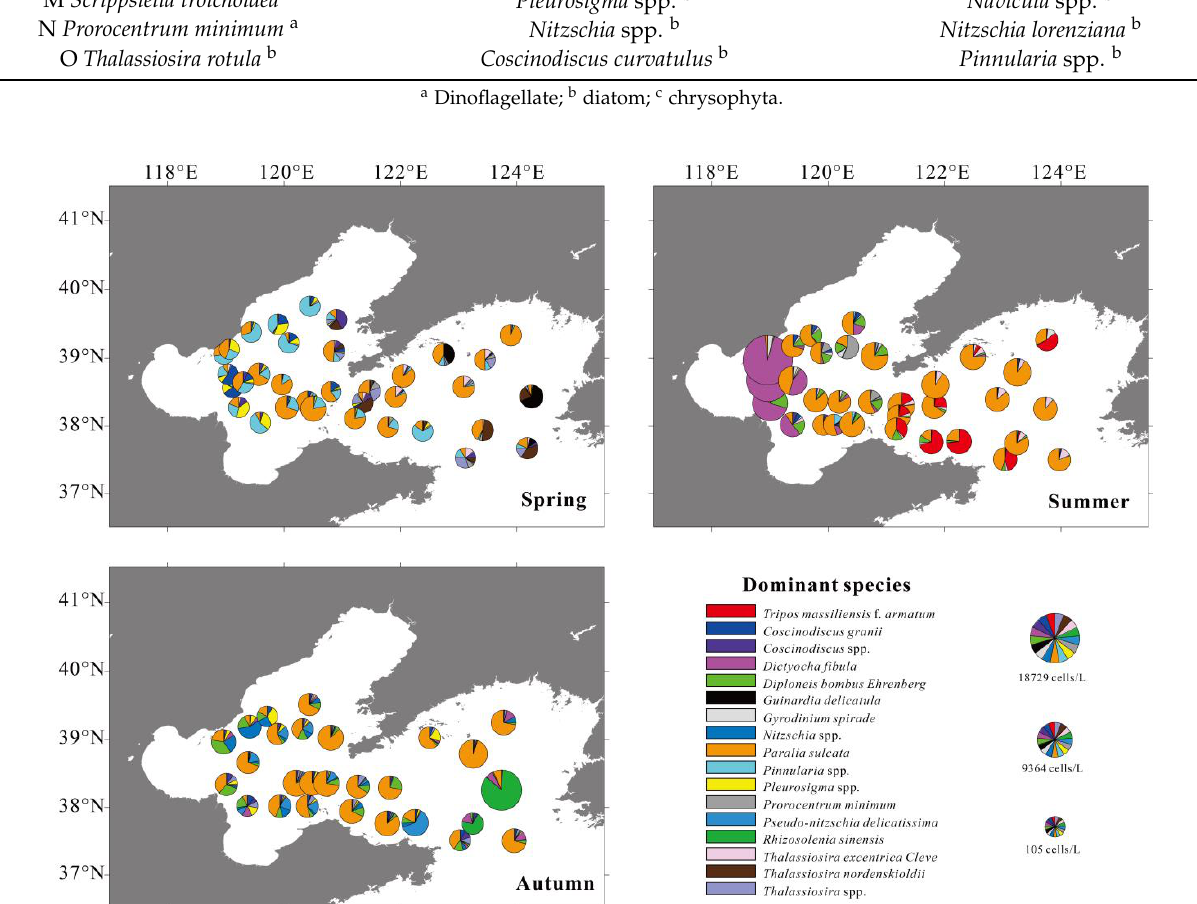
Table 4. The diversity index (H) and evenness index (J) of phytoplankton community in three seasons (spring, summer, and autumn) in the BS and NYS.